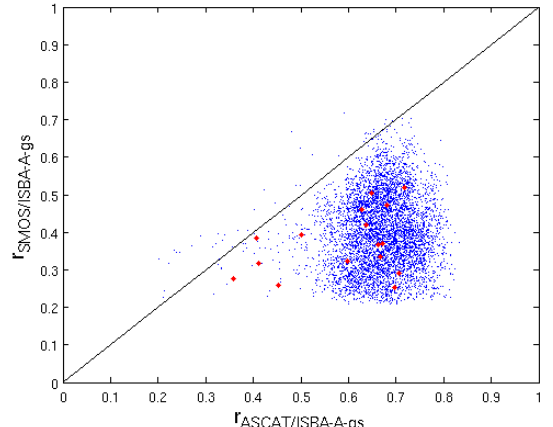
Fig. 5. SMOS-L2 vs. ASCAT SSM anomaly correlation coefficients with the ISBA-A-gs simulations for each ISBA-A-gs grid cell. Red dots represent the ISBA-A-gs grid-cells corresponding to SMOSMANIA stations. Only points presenting significant correlations (p-value < 0.05) for both SMOS-L2 and ASCAT are shown.